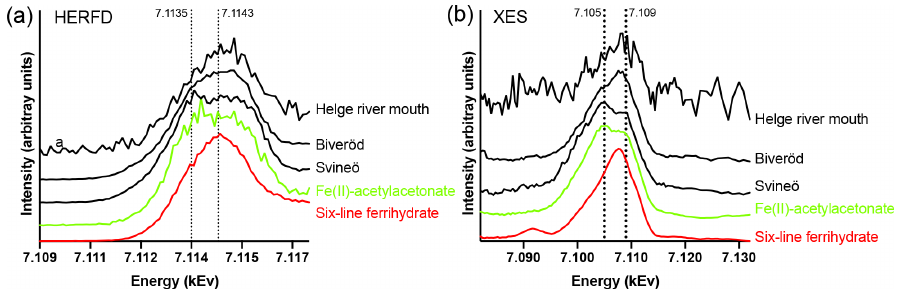
Figure 3. Fe K-edge HERFD pre-edge spectra (a) and K β 2 , 5 X-ray emission (XES) spectra (b) of the Helge river mouth sample, the Biveröd sample, the Svineö sample, Fe(II)-acetylacetonate (Fe(acac) 2 ) (green), and six-line Ferrihydrite (red). The spectra were normalized to the maximum intensities. The dotted lines are included for visual guidance.